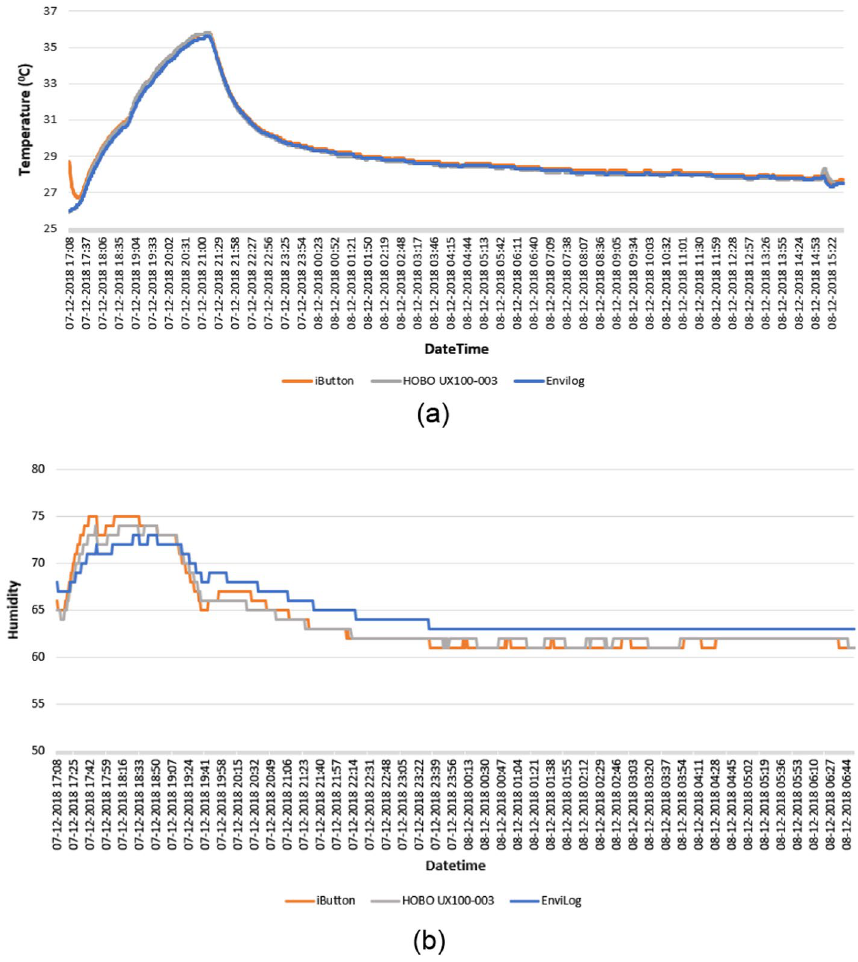
Fig. 8 a Temperature and b humidity graph plotted against datetime for Envilog, iButton and HOBO